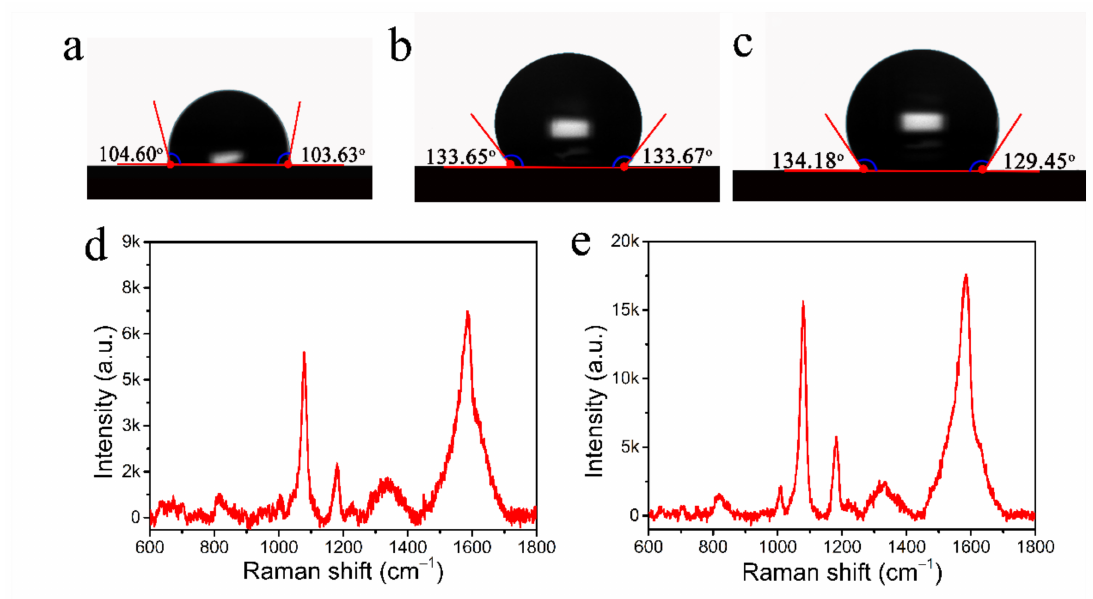
Figure 5. Variation in contact angle with the volume ratio of PFDT ethanol solution changed to ( a ) 1:1000 ( b ), 1:500 and ( c ) 1:250. ( d , e ) 4-ATP SERS spectra at 10 − 7 M concentration on the normal substrate and hydrophobic